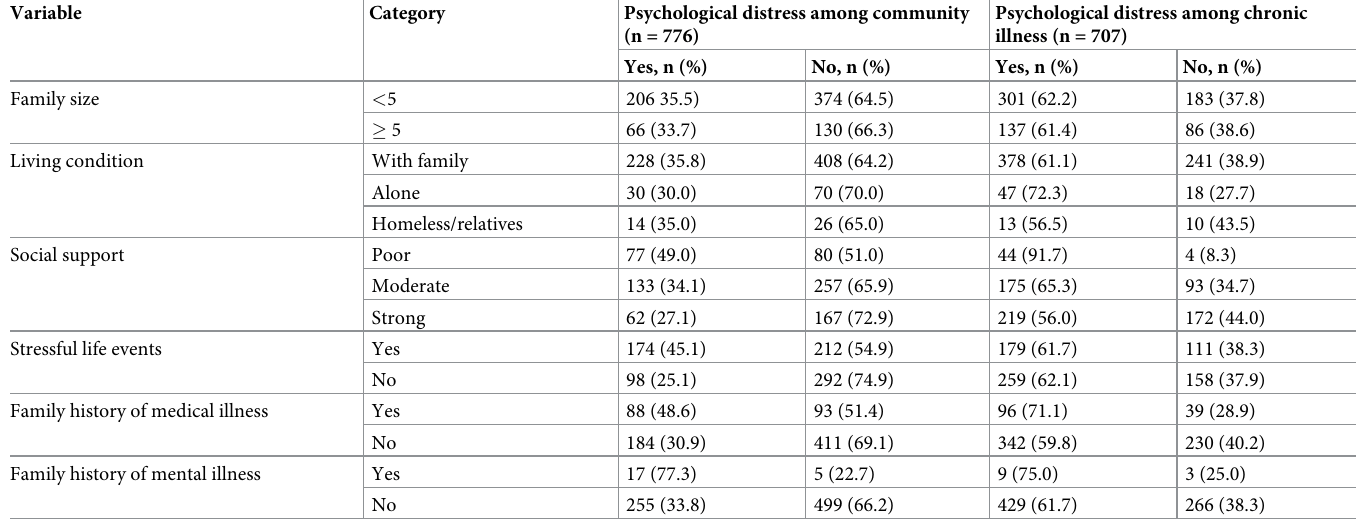
Table 5. Psychological distress distribution among people living with chronic medical illness and general community participants in Mecha demographic research center,